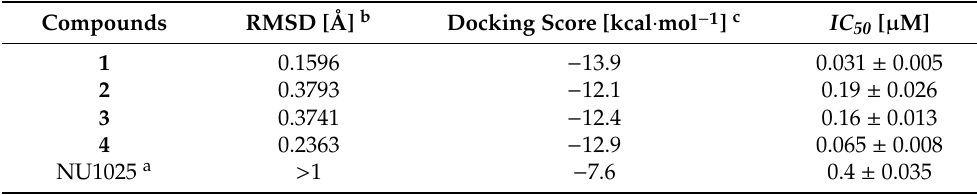
Table 3. Hit compounds selected from an in-house database.